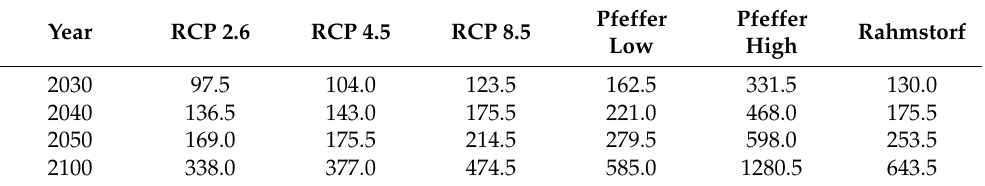
Table 6. Volume required to renourish Victoria Beach (m 3 /m) for the projected years 2030, 2040, 2050, and 2100, according to the different models and scenarios.